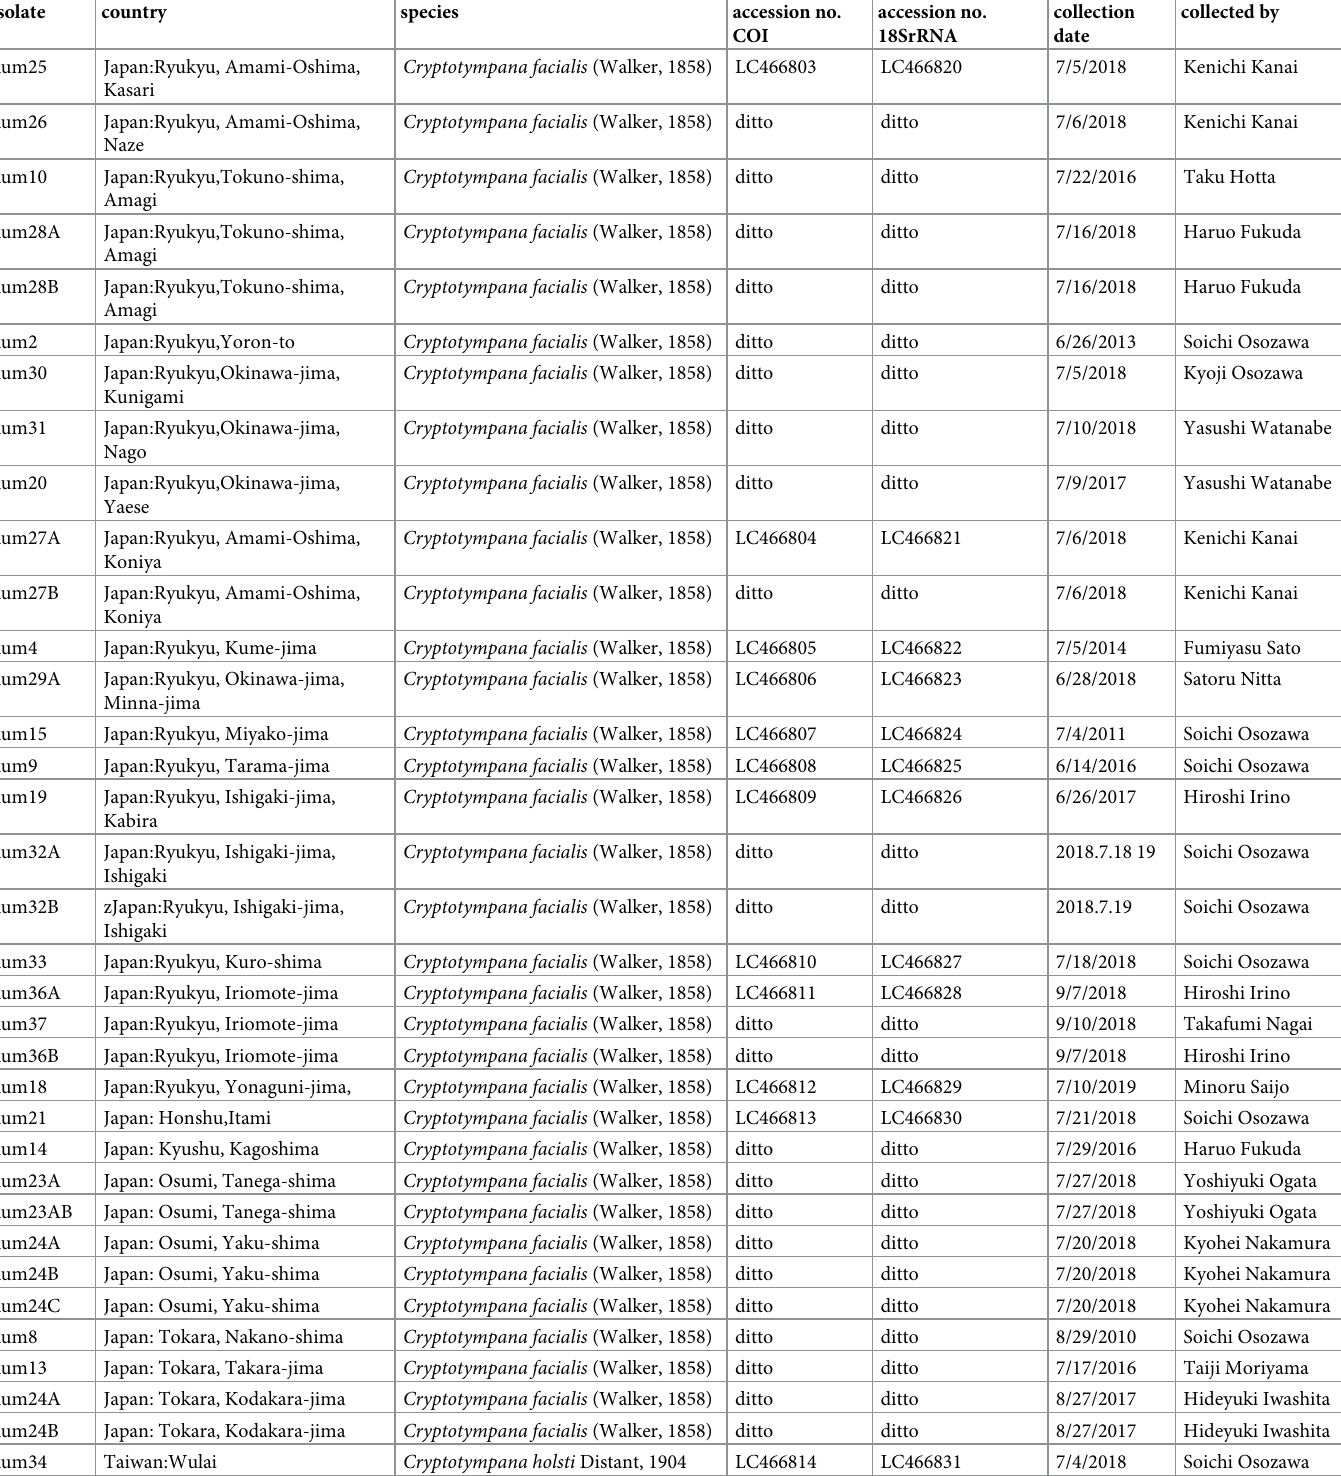
Table 1. Cicada species collected and analyzed in this paper. isolate country